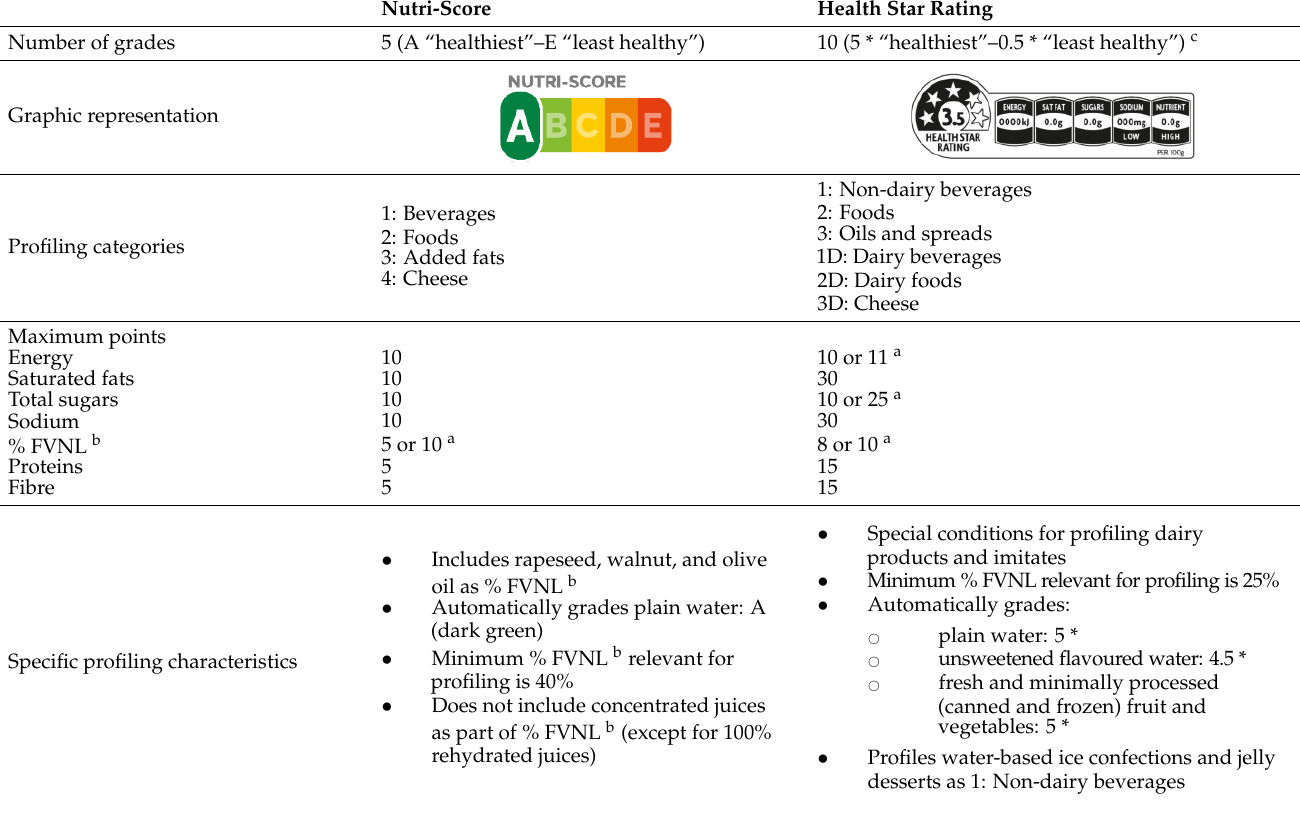
Table 1. Differences between Nutri-Score and Health Star Rating nutrient profiling models.